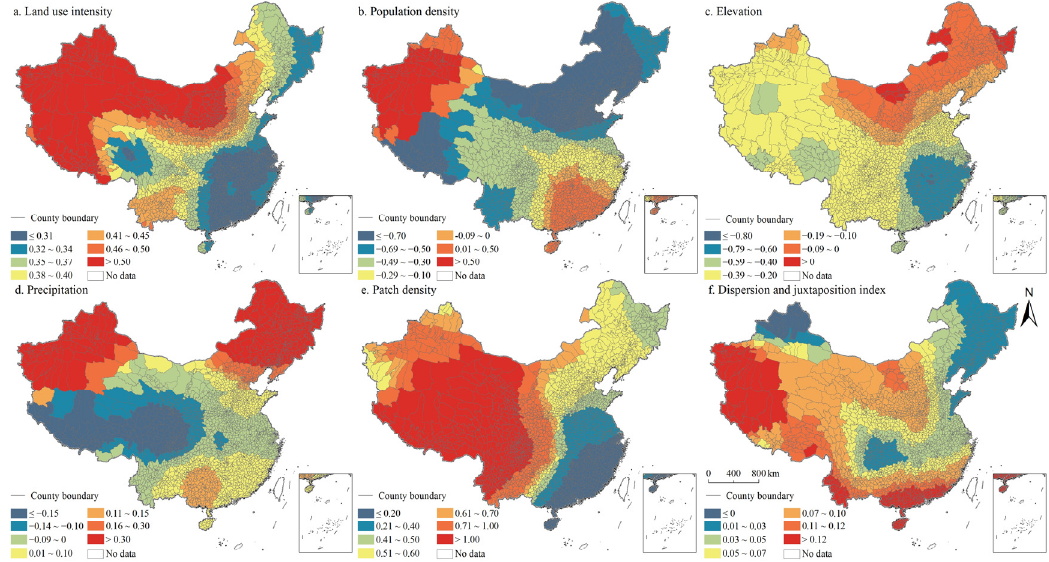
Figure 15. Spatial distributions of the regression coefficients of GWR models in China in